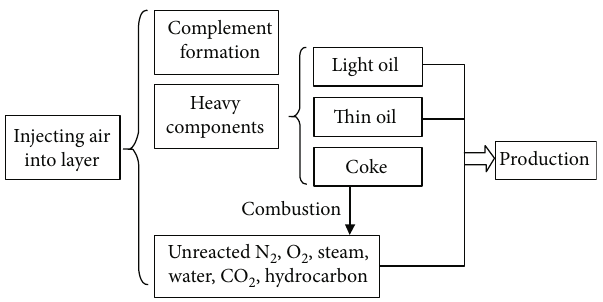
Figure 1: Material transport process in fi re fl